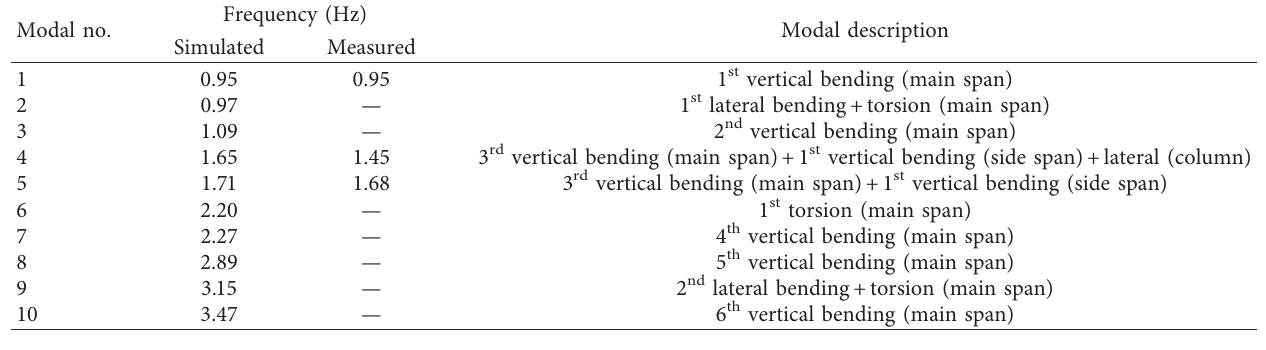
Table 4: Dynamic characteristics of the bridge.